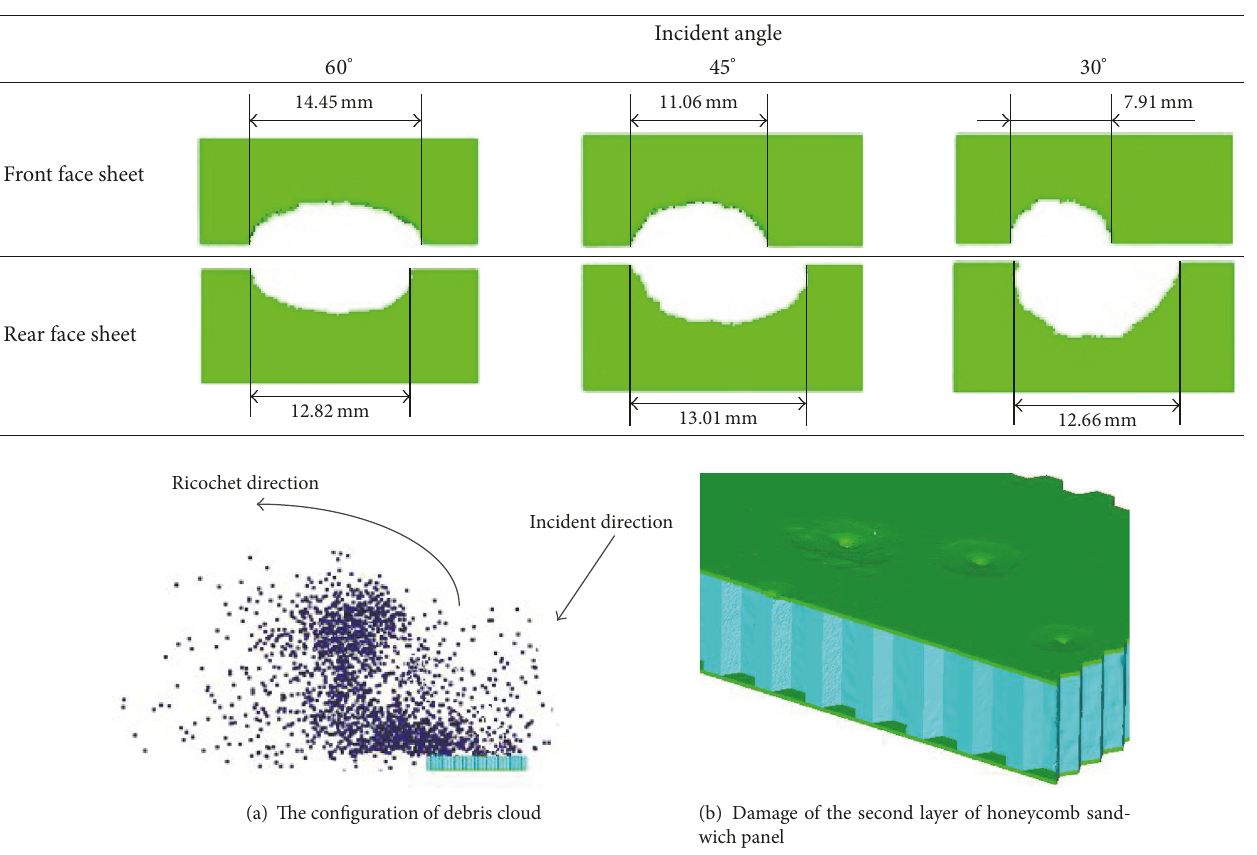
Figure 7: Second layer of honeycomb sandwich panels (incidence angle is 30 ∘